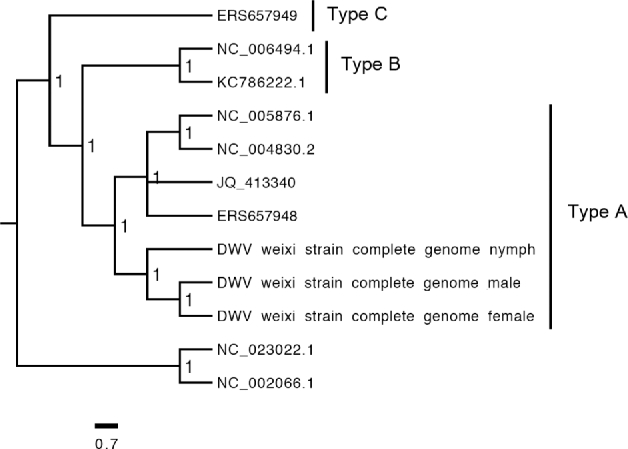
Classification of DWV in the T. mercedesae transcriptomes. The Bayesian phylogeny was constructed using Mrbayers based on the amino acid sequences of complete DWV genomes assembled from the adult males, adult females and nymphs transcriptomes (DWV weixi strain complete genome male, DWV weixi strain complete genome female, and DWV weixi strain complete genome nymph) as well as seven other DWV strains (type A variant: NC_005876.1, NC_004830.2, JQ_413340, and ERS657948; type B: KC_786222.1 and NC_006494.1; type C: ERS657949). The tree was rooted with Formica exsecta Virus 1 (NC_023022.1) and Sacbrood Virus (NC_002066.1).